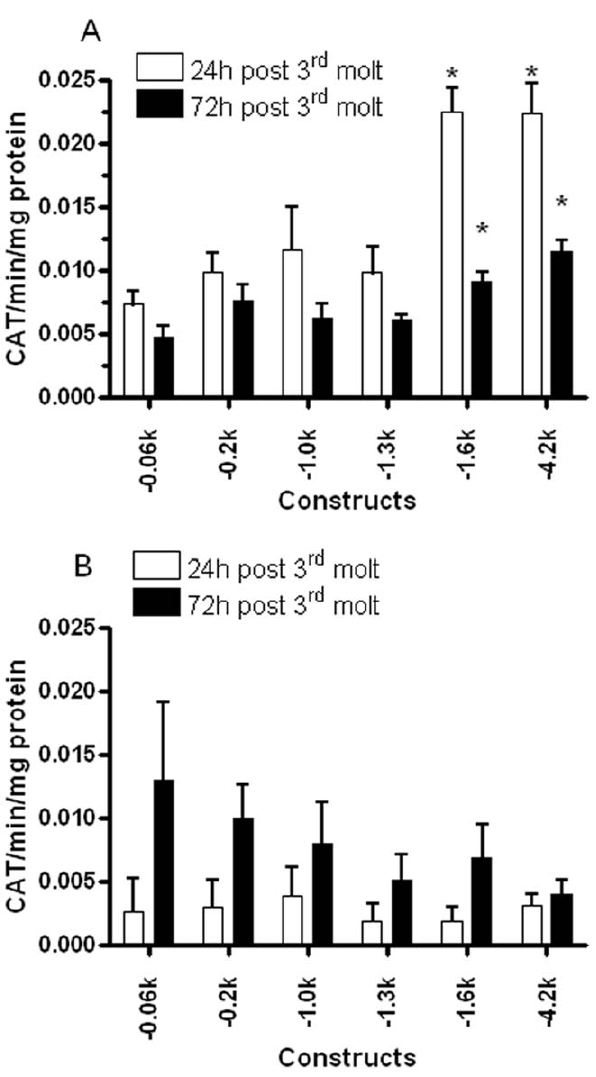
nized 4 th instar larvae (30 larvae/sample) were taken at 24 and 72 hours post 3 rd molt. ( B ) The carcass samples were from the same larvae as